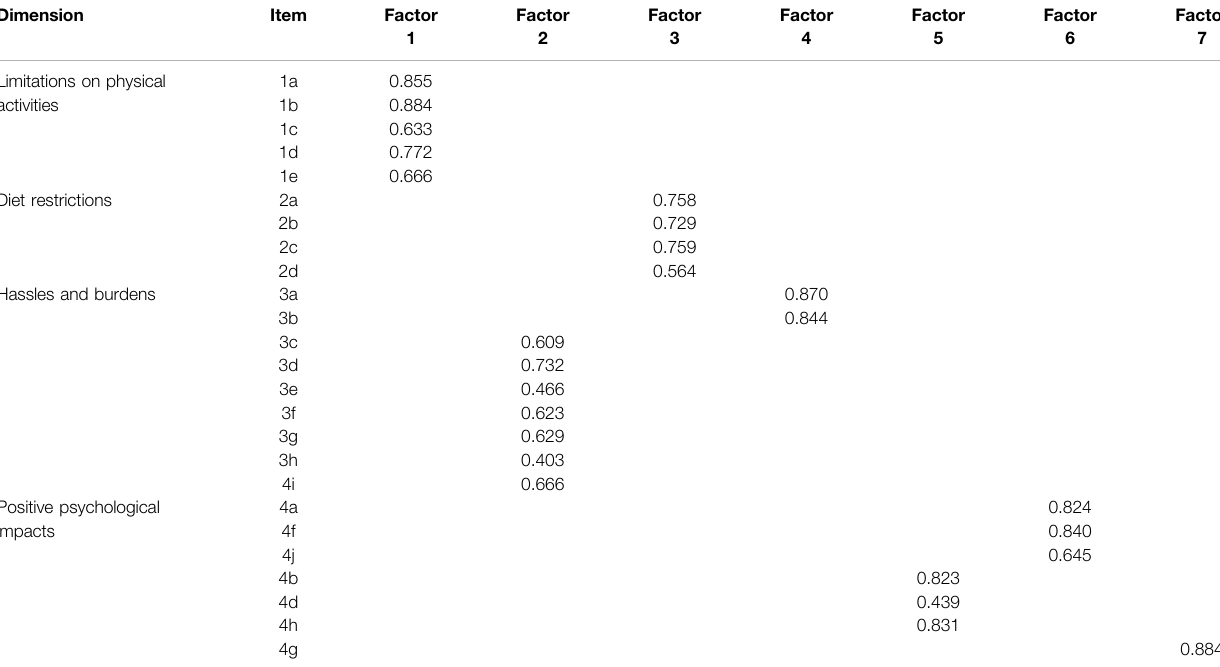
TABLE 2 | Factor load coef fi cients for items of Chinese DASS.